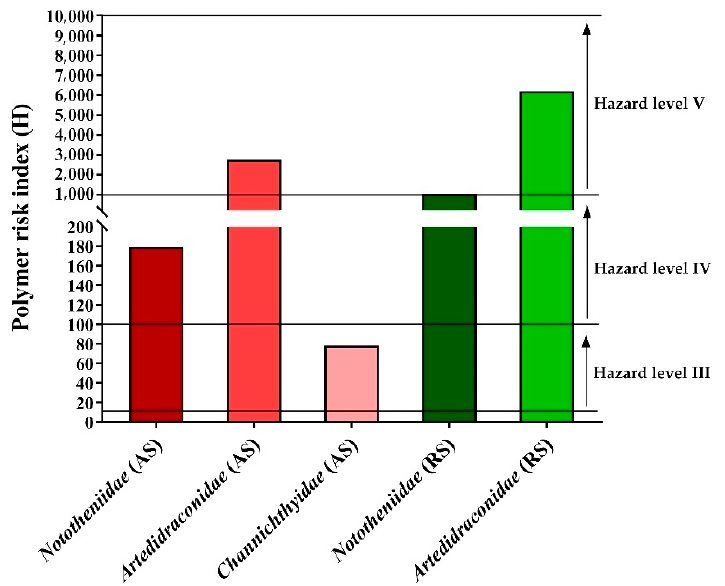
Figure 8. The polymer risk index (H) and hazard level of MP contamination in three fish families in the AS and two fish families in the RS. Family Bathydraconidae in the AS, family Channichthyidae in the RS, and family Zoarcidae in the RS were not shown in figure because there were no MPs detected in them. Family Zoarcidae in the AS was not shown in figure because there was no available hazard score of the MPs rayon detected in this fish family.